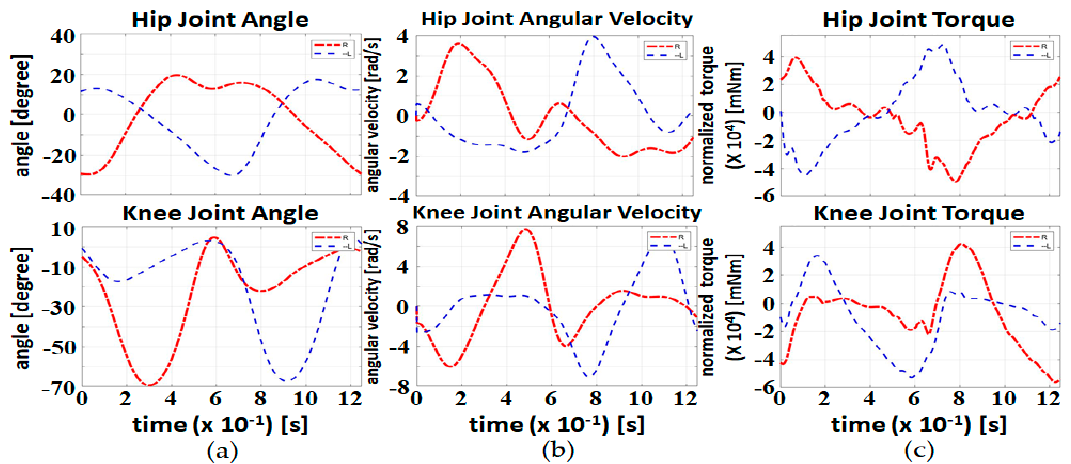
Figure 11. Joint data of one gait cycle obtained from the open source software: ( a ) joint angle; ( b ) joint angular velocity; ( c ) normalized joint torque. The red dot-dashed line and blue dashed line represent the data of the right leg and the left leg, respectively.